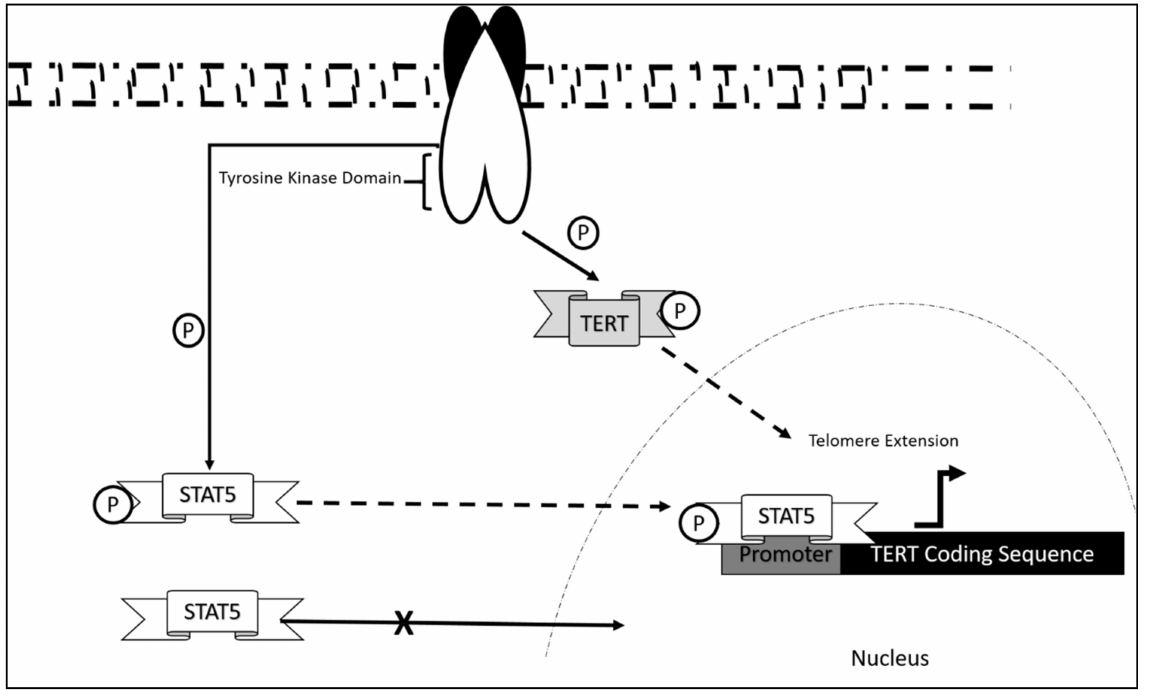
Figure 2. BCR-ABL control of TERT activity and expression generally targeted via Imatinib Mesylate or Tyrosine Kinase Inhibitor